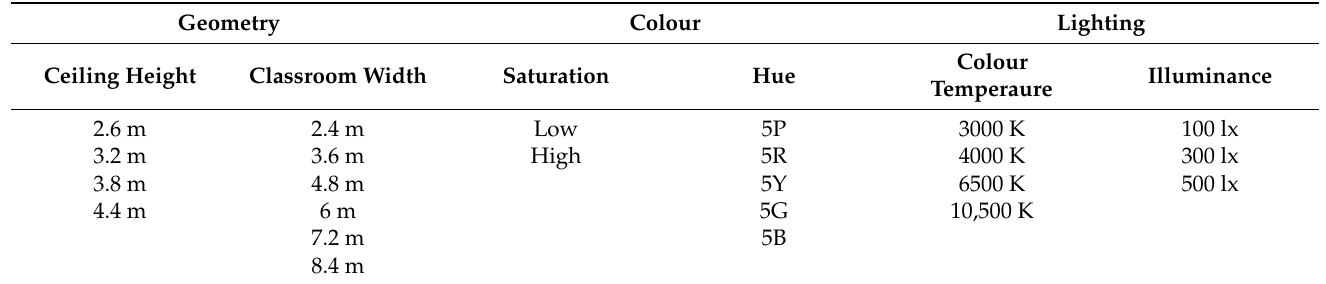
Table 3. Set of parameters studied.